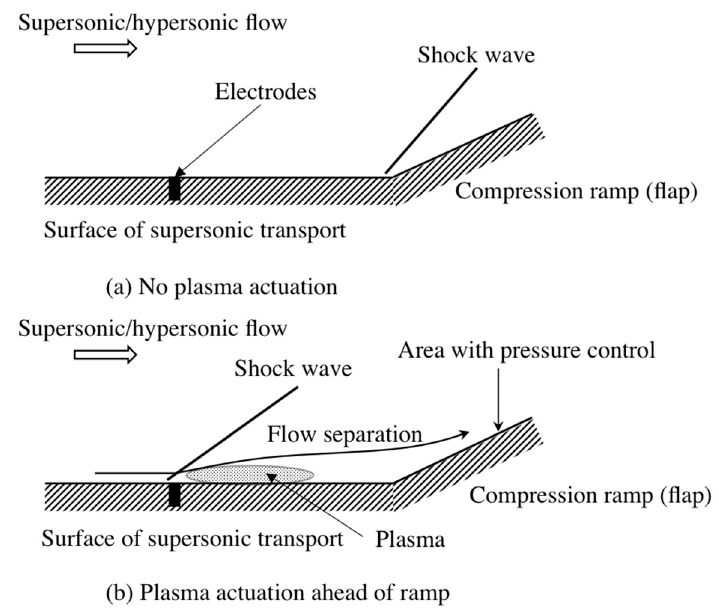
Figure 1. Schematic diagram of plasma-assisted flow control at electrodes installed in front of deflected flap (ramp).